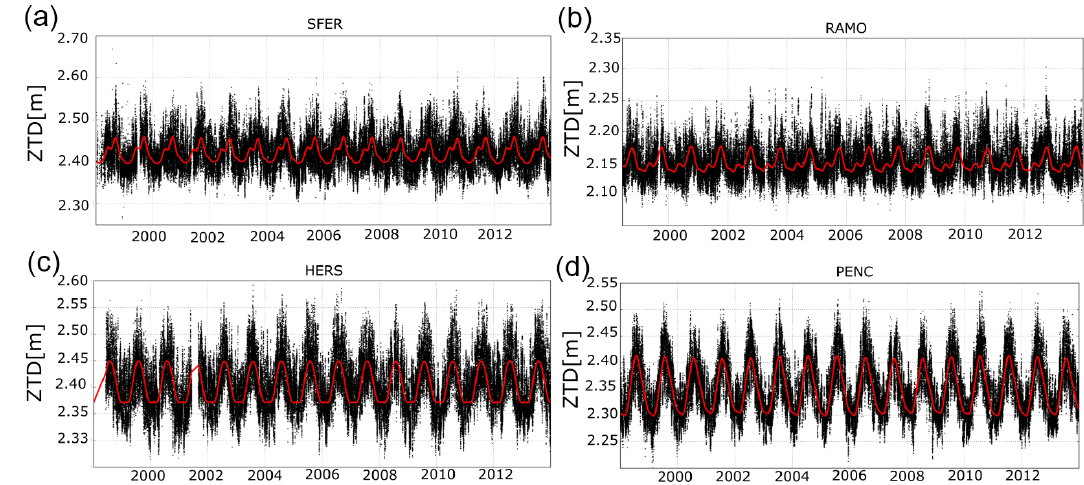
Figure 4. ZTD time series for SFER (a) , RAMO (b) , HERS (c) , and PENC (d) stations with fitted oscillations.